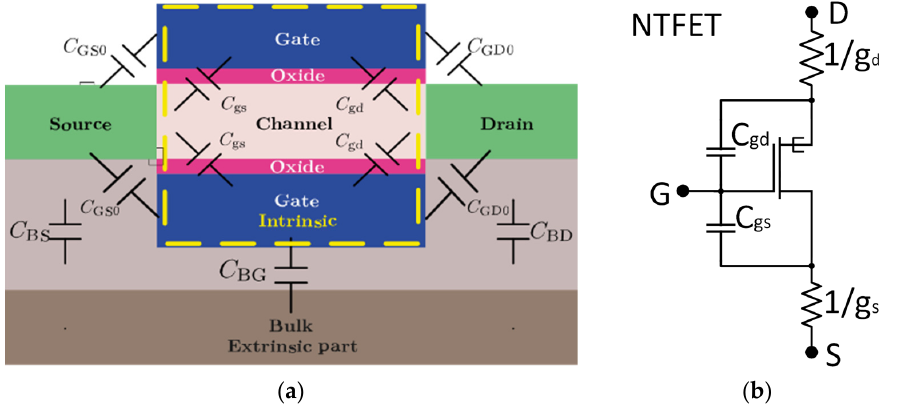
Figure 6. Description of the model used for the parasitic components of the TFET: ( a ) the capacitive contribution related to the TFET architecture (transversal cut) considered based on the model in [22], ( b ) the electrical circuit model resulting from the capacitive parasitic components.